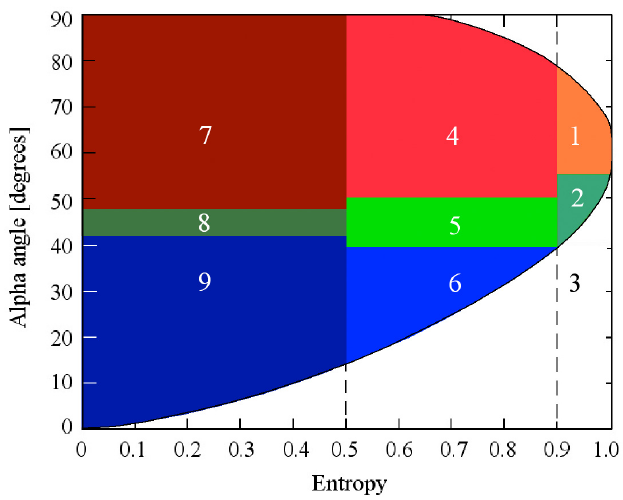
Figure 16. Classification scheme based on the scattering process using the entropy H and alpha angle ¯ α